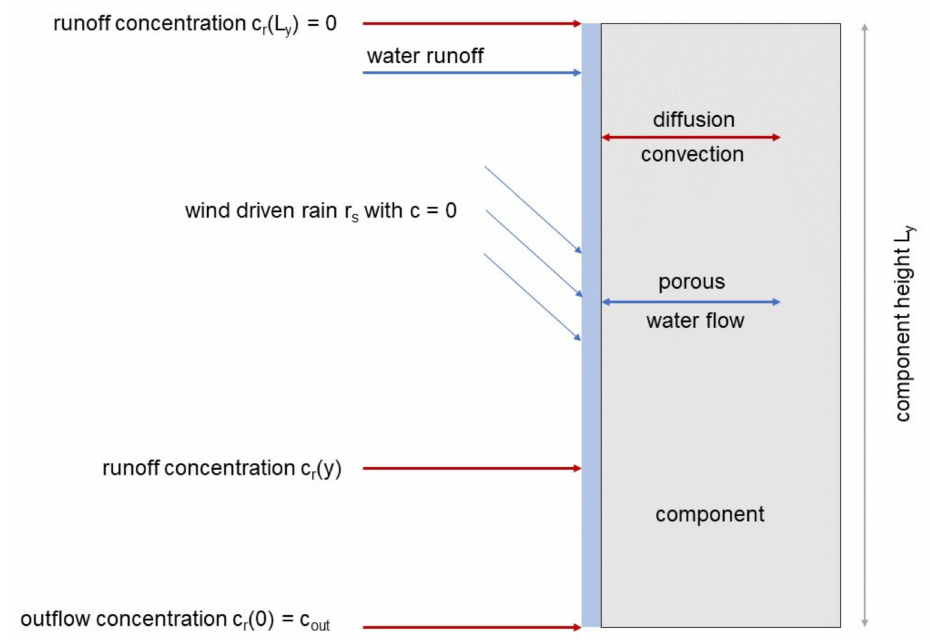
Figure 6. Leaching processes in a building material at a